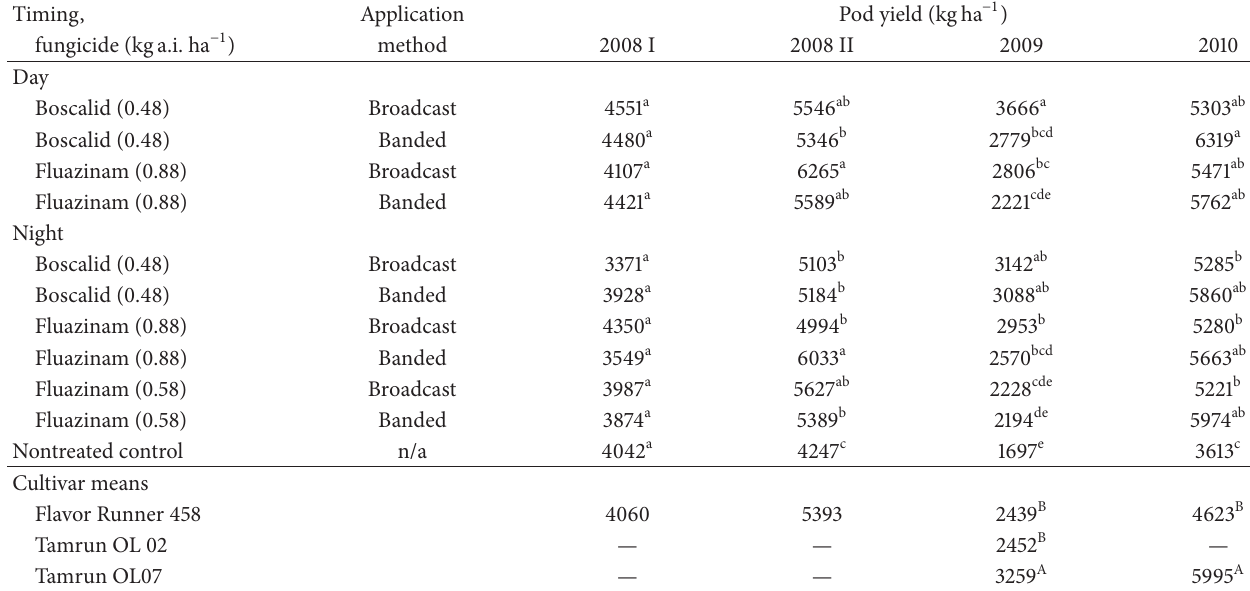
Table 4: Effect of broadcast and banded applications of the fungicides boscalid and fluazinam applied at different times of the day on peanut yield a